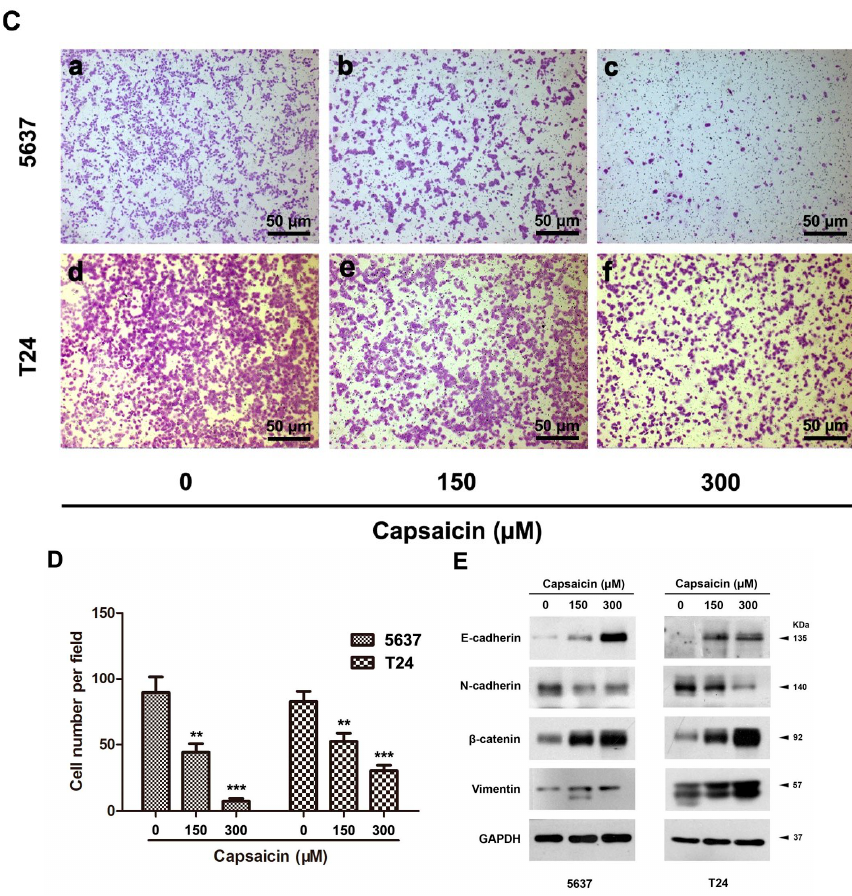
Figure 1. Capsaicin inhibits BCa cell proliferation and migration in vitro. ( A , B ) Relative cell proliferation of 5637 and T24 cells treated by CAP at distinct concentrations (0, 50, 100, 150, 200 and 300 µM) for 48 h were measured by MTT assay, to determinate the appropriate concentrations of